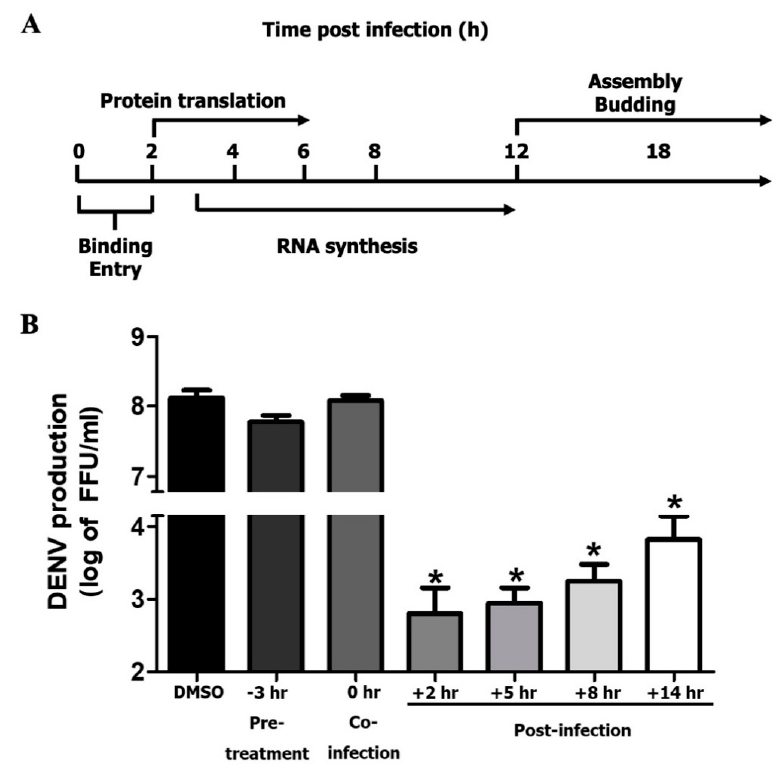
Figure 4. Time-of-addition study of MEL on DENV2-infected Huh7 cells. ( A ) Schematic timeline of DENV replication cycle. ( B ) Huh7 cells were treated with MEL prior to DENV2 infection (pre- treatment), during DENV2 infection (co-infection), or after infection (post-infection) at the indicated time-points. Culture supernatants were harvested at 24 h pi and viral titration was done. The asterisk (*) sign denotes p < 0.05 considered to be statistically significant.